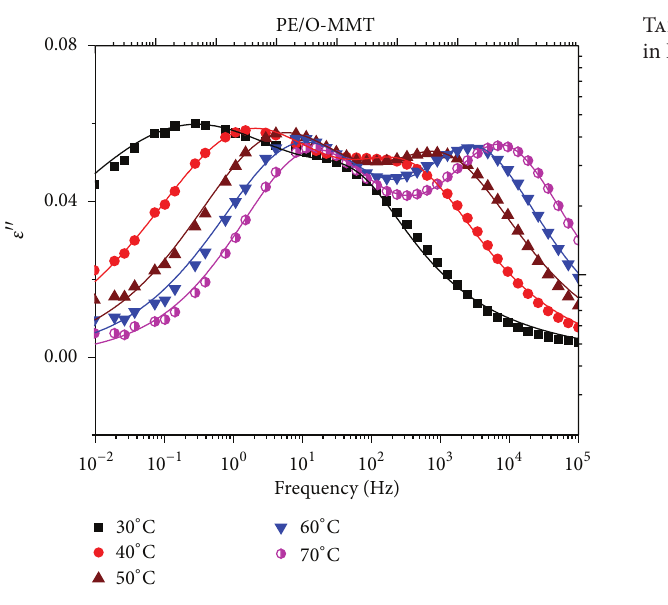
Figure 8: Dielectric loss 𝜀 󸀠󸀠 for PE/O-MMT nanocomposites versus frequency at different temperatures with the optimum fitting curves for the Havrilialk-Negami equation.